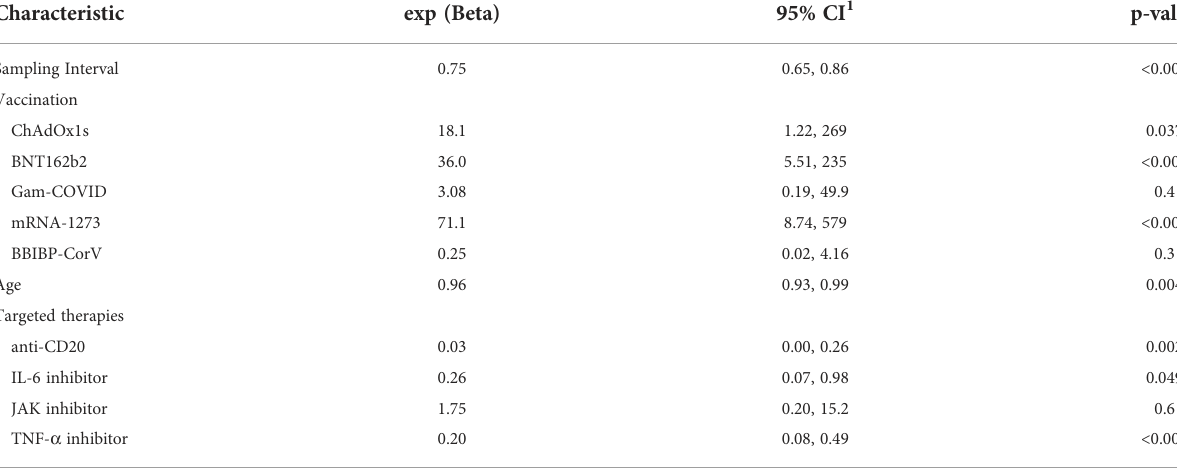
TABLE 3 Parameters of the optimized regression model for anti-S antibodies.